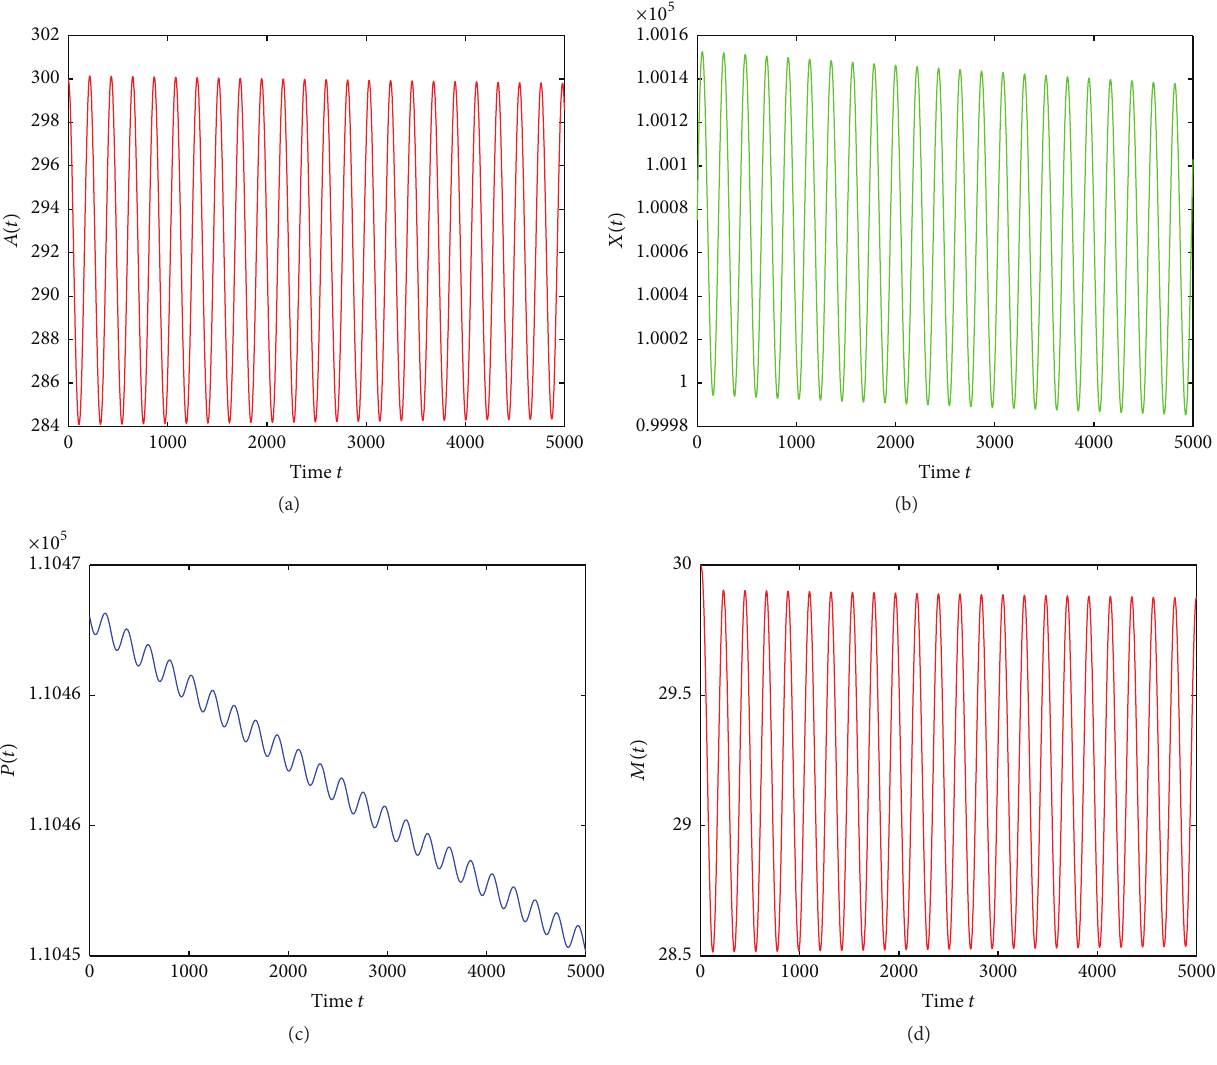
Figure 6: Hopf bifurcations occur with 𝜏 = 2.50 > 𝜏 0 = 1.5767